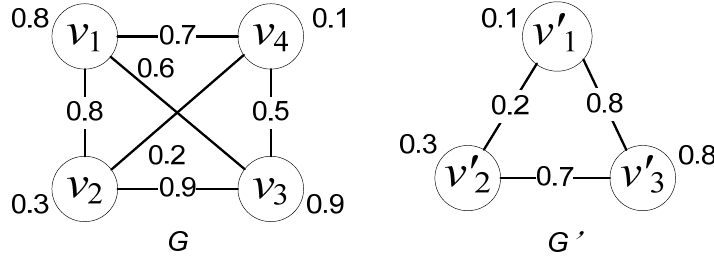
Figure 4. An example of ARG matching ([26]).